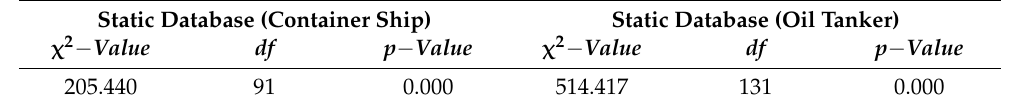
Table A3. Little’s MCAR